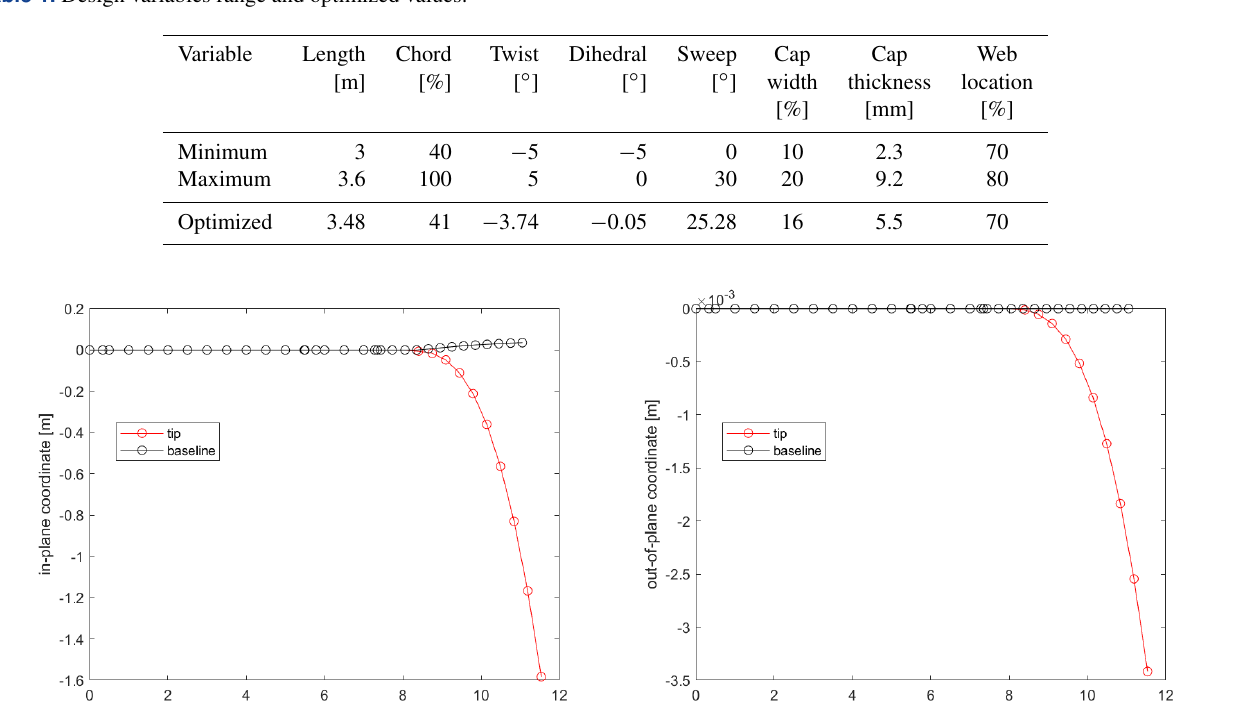
Table 1. Design variables range and optimized values.